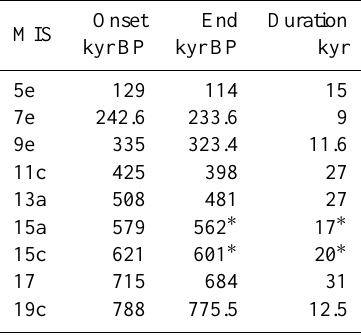
Table 1. Timing of the onset and end of interglacials of the last 800kyr and their estimated